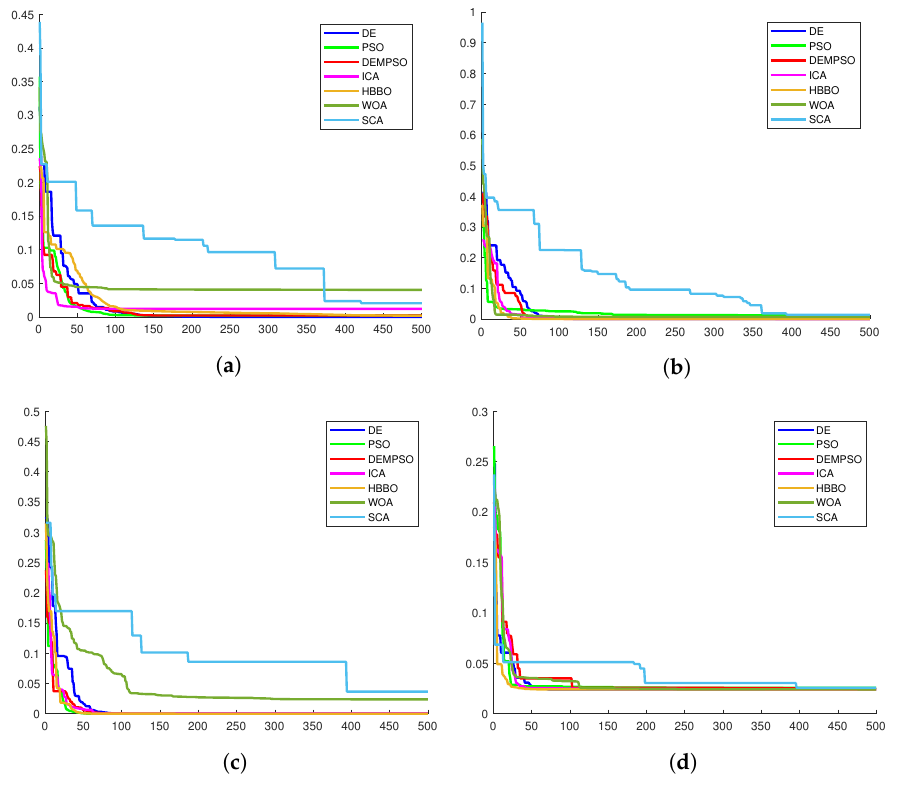
Figure 12. Convergence curves for the four robots. ( a ) Convergence curves for the Baxter robot); ( b ) Convergence curves for the Fanuc robot; ( c ) Convergence curves for the Puma robot; ( d ) Conver- gence curves for the Youbot